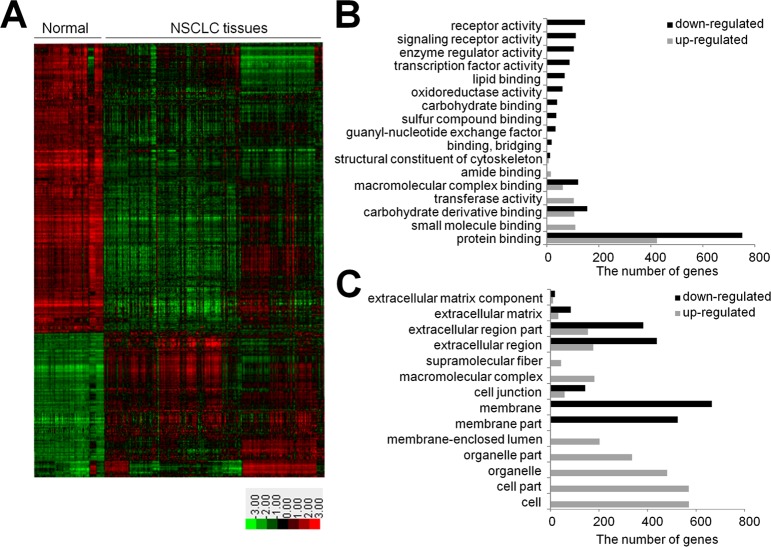
Analyses of 9 transcriptome datasets from the GEO.(A) A heat map of 2,696 differentially expressed probes between tumor (n = 669) and non-tumor tissues (n = 218) collected from 9 GEO data sets (p-values < 1 x 10−6 and over two-fold changes; red: up-regulation; green: down-regulation) (B) Classification of DEGs based on their molecular function as suggested by DAVID. (C) Subcellular locations of DEGs (grey: up-regulated genes in NSCLC; black: down-regulated genes in NSCLC).